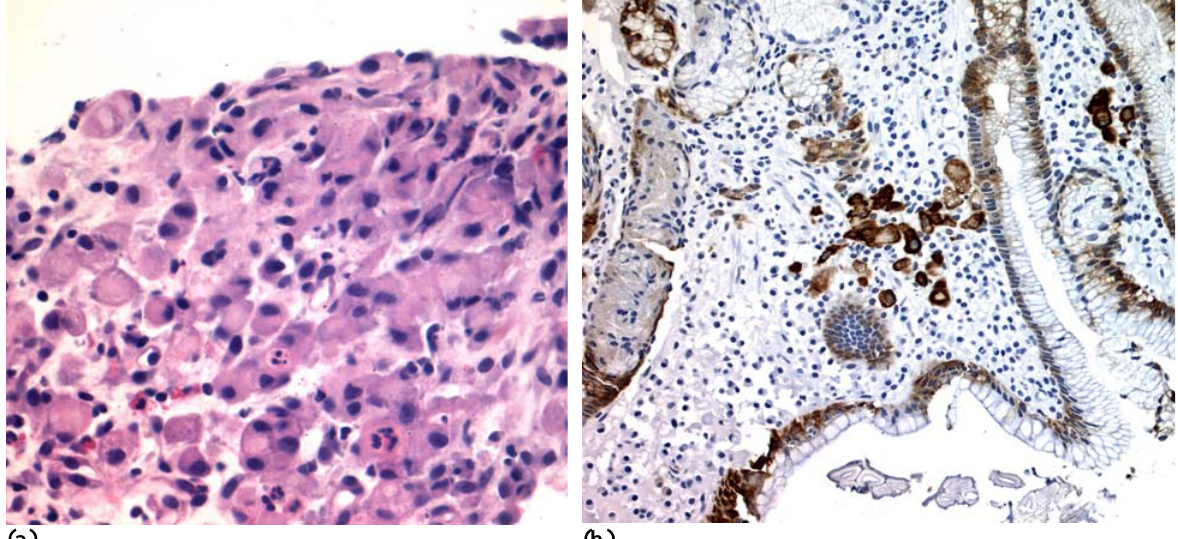
FIGURE 5. Histology of gastric mucosal biopsies. (a) Hematoxylin-Eosin (400x) and (b) anti-cytokeratin (200x) stain of some signet ring cells of a diffuse gastric